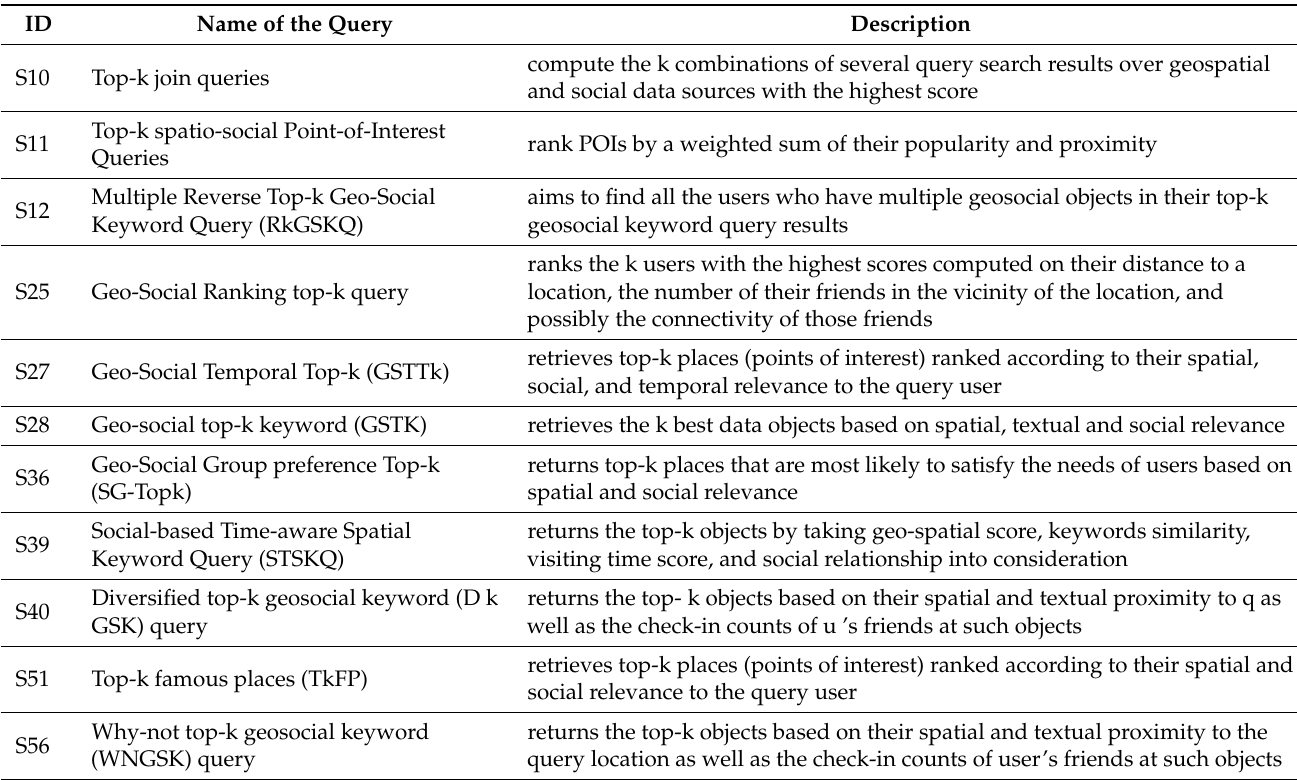
Figure 8. An example of a geosocial top-k query that considers the query location q, a set of places {p1, p2, p3}, and a set of users {u1, u2, . . . , u7}. The table on the right side shows the spatial distances between the query location and places, the number of visitors of each place, and the score of each place, according to the scoring function. Table 10. Geosocial top-k queries.